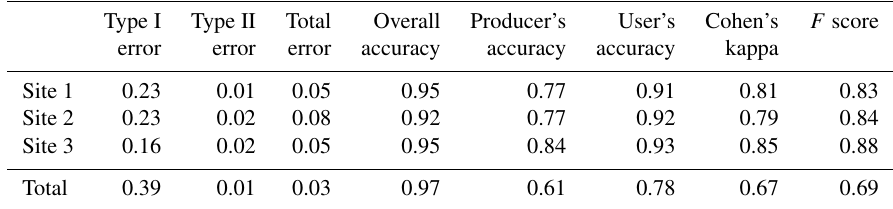
Table 1. Performance metrics estimated for 4km − 2 training sites 1–3 (see Figs. 3 and 5) and for the entire study area covering 226.3km − 2